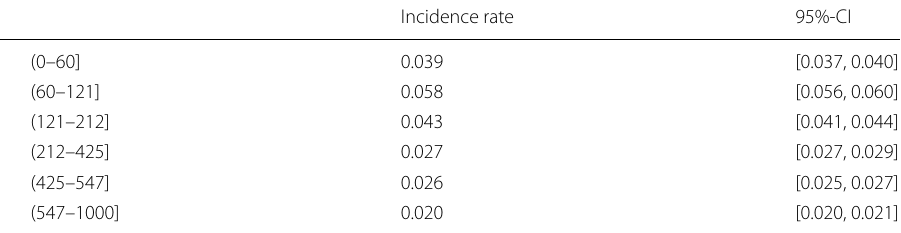
Note: Incidences of non‑completion per person‑time, meaning the sum of duration in days of all observed apprenticeships in the